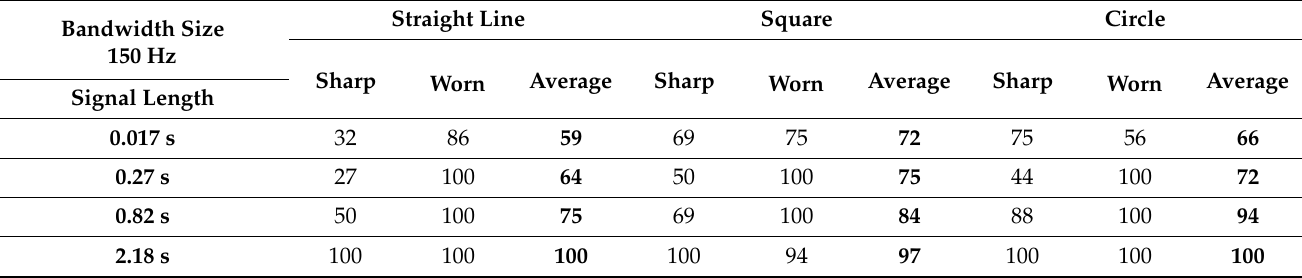
Table 4. Tool wear classification rate with the X-axis vibration signal and a 150 Hz bandwidth size (model trained by straight line data).